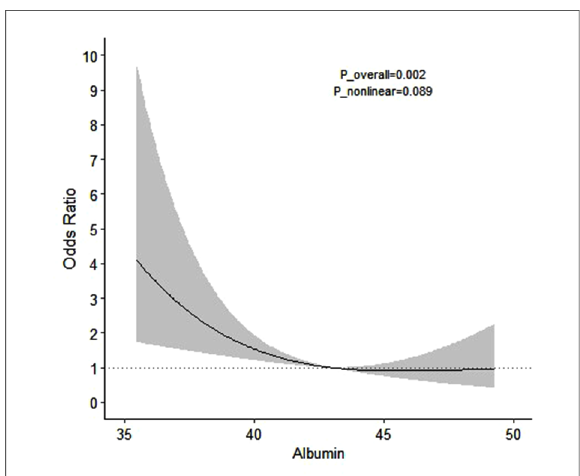
FIGURE 2 Dose-response relationship between preoperative albumin levels and the risk of acute postoperative